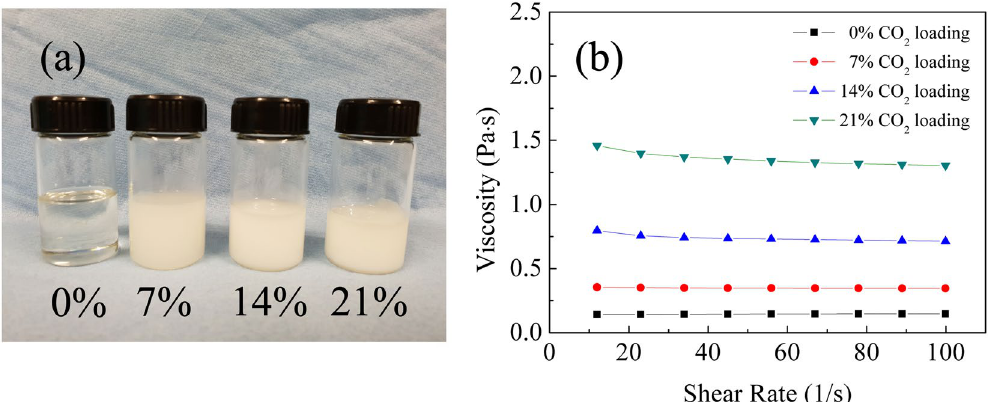
Figure 3. ( a ) Photos of DBU/glycerol mixtures with different loading of CO 2 , ( b ) Viscosity at different shear rates after CO